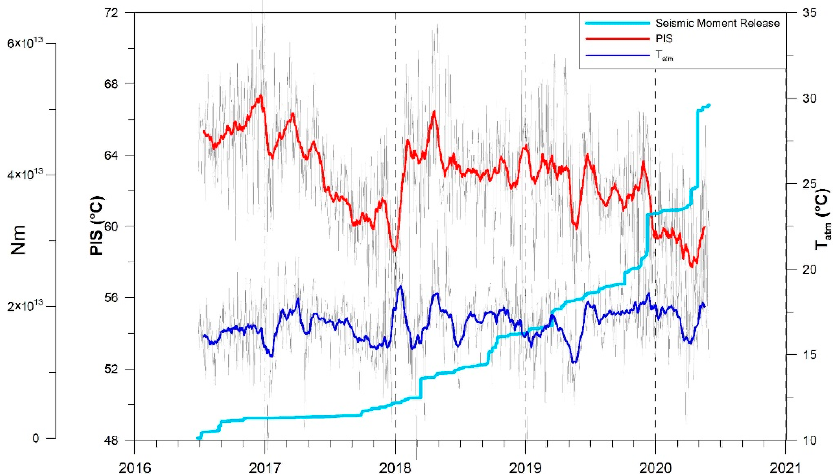
Figure 7. Seismicity. Comparison among the TIR time-series at Pisciarelli (red line marks 31, moving average), the atmospheric temperature (blue line marks 31, moving average) and the seismic moment release (cyan).